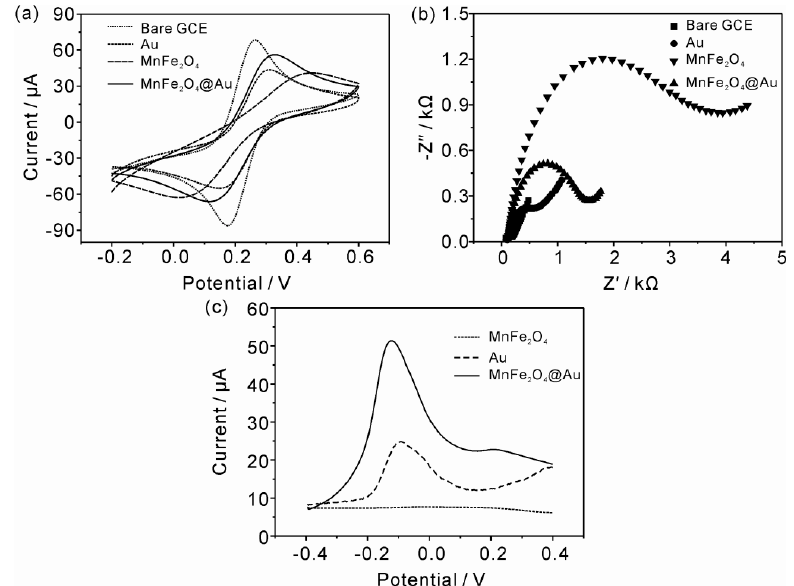
Figure 2. Cyclic voltammograms ( a ) and Nyquist diagram of electrochemical impedance spectra ( b ) for bare glass carbon electrode (GCE), Au nanoparticles (NPs), MnFe 2 O 4 NCs, MnFe 2 O 4 /Au hybrid nanospheres modified GCE in the solution of 5 mM Fe(CN) 6 3 − /4 − containing 0.1 M KCl. ( c ) SWASVs (square wave anodic stripping voltammetries) for 50 ppb As(III) on the MnFe 2 O 4 NCs, Au NPs, MnFe 2 O 4 /Au hybrid nanospheres modified GCE in 0.1 M HAc-NaAc (pH 5.0). Deposition potential: - 0.9 V, deposition time: 150 s, step potential: 4 mV, amplitude: 25 mV, frequency: 25 Hz, vs. Ag/AgCl.